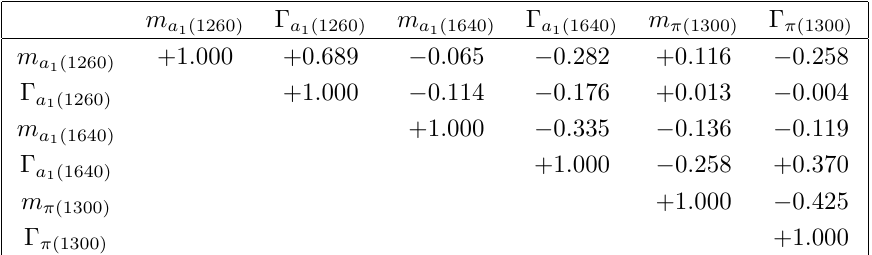
Table 5 . The statistical correlation coe(cid:14)cients between the resonance parameters determined from the D 0 ! (cid:25) + (cid:25) (cid:0) (cid:25) + (cid:25) (cid:0)